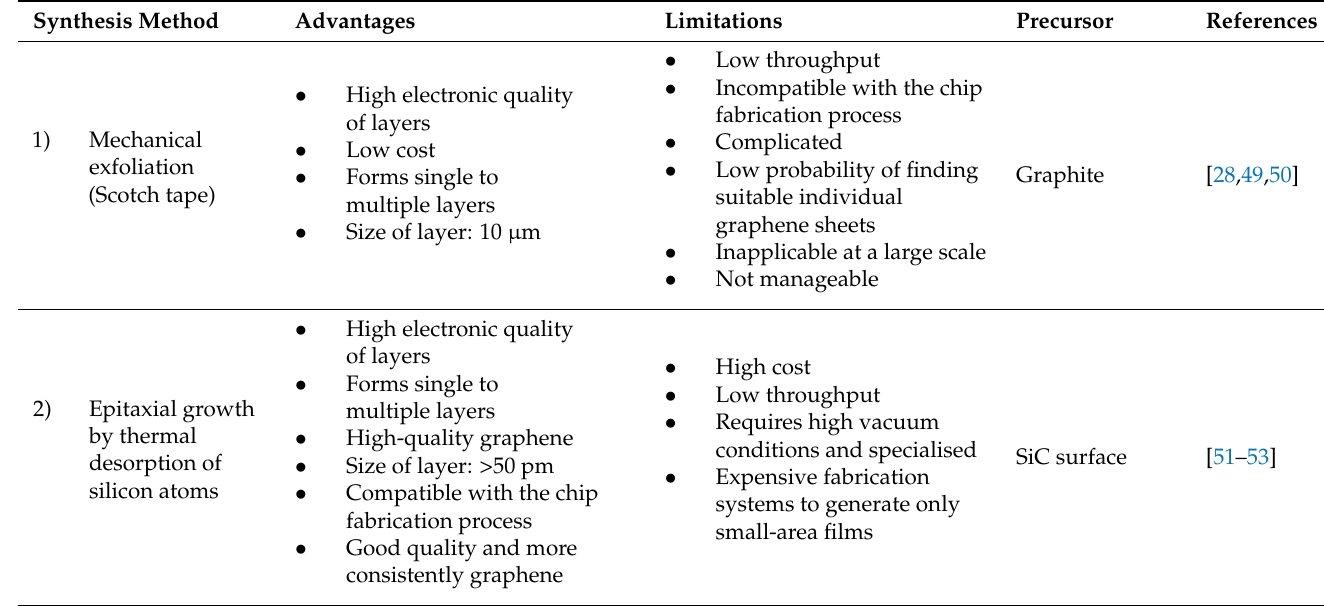
Table 2. Synthesis method of graphene and its derivatives (e.g.,